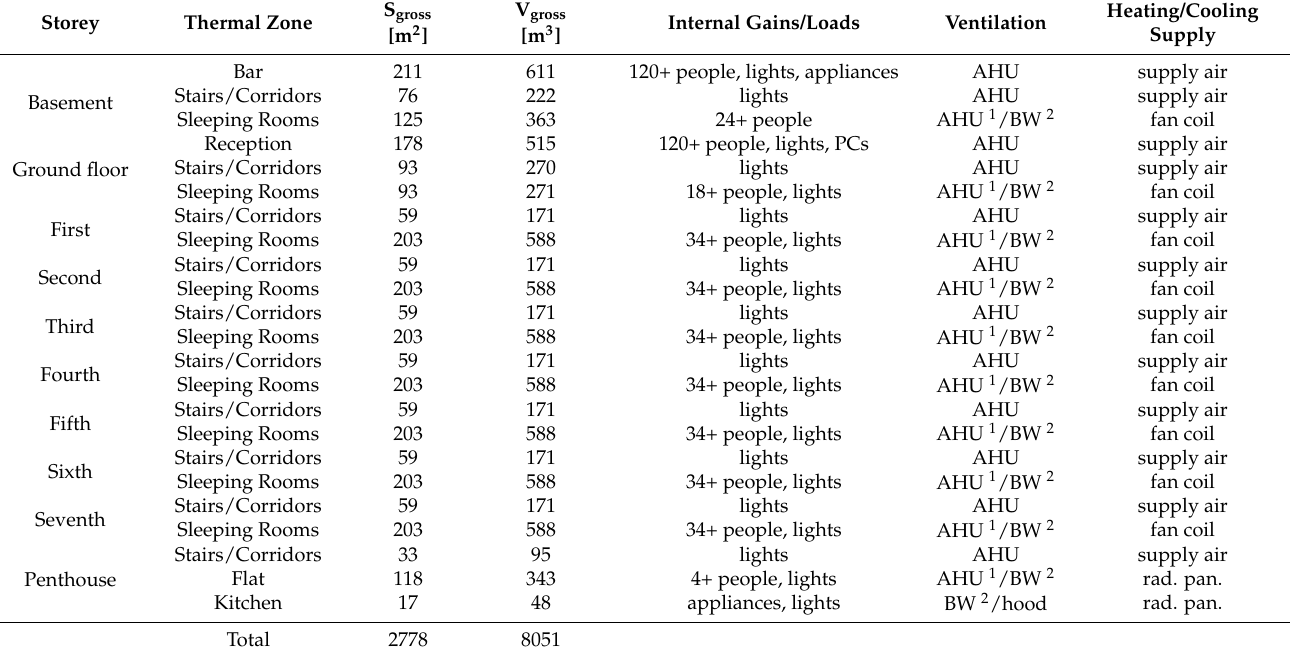
Table A1. Characterization of the thermal zones in the numerical model of the project and the BAU scenario, in terms of gross floor surface (S gross ), gross internal volume (V gross ), overall internal gain contributions, ventilation technology, and emission system.